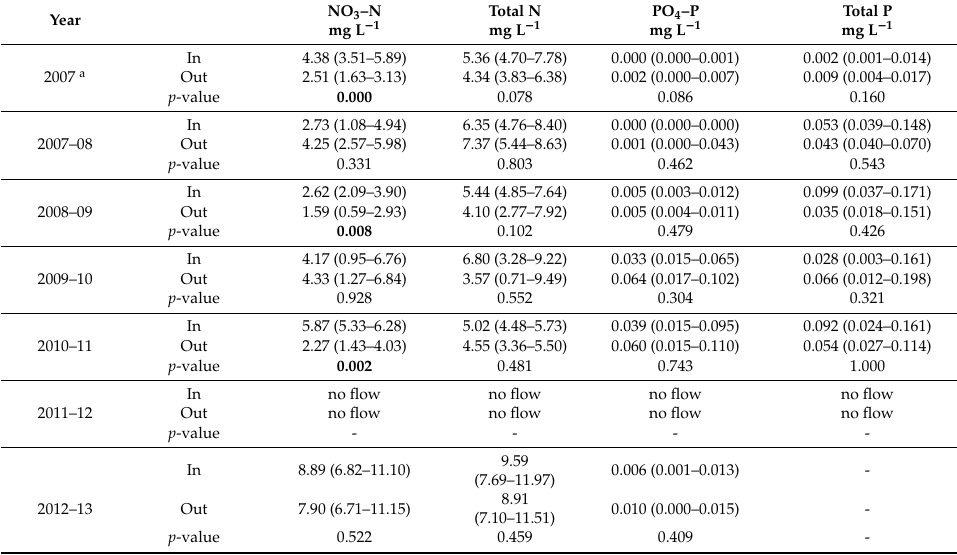
Figure 4. NO 3 –N ( a ) and total N ( b ) monthly flow-weighted inlet and outlet concentrations. N fertilizer applications are reported. Table 2. Annual inlet and outlet N and P concentrations (median and interquartile range). Data is organized into hydrological years (October–September). p -values of the Mann–Whitney nonparametric test are reported (significant di ff erences in